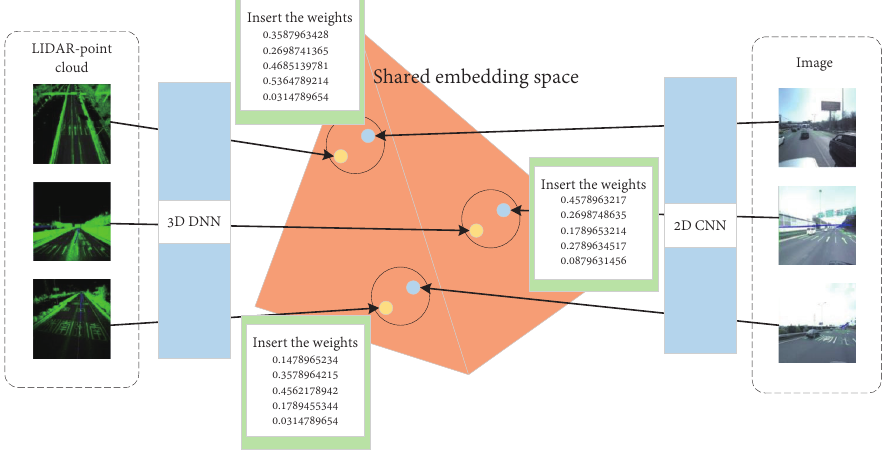
Figure 25. Flowchart of the DNN-based LIDAR–camera fusion method. Reproduced with permission of Ref. [218], Copyright of 2020